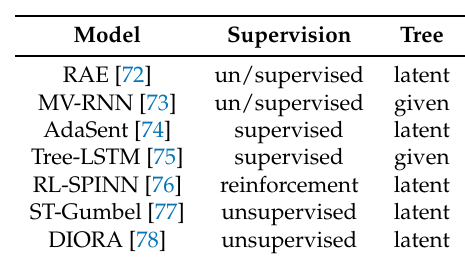
Table 3. The categorization of recursive models by supervision and parsing tree source. All the listed models work with word-level input and learn sentence+ representations. Un/supervised supervision represents both unsupervised and supervised